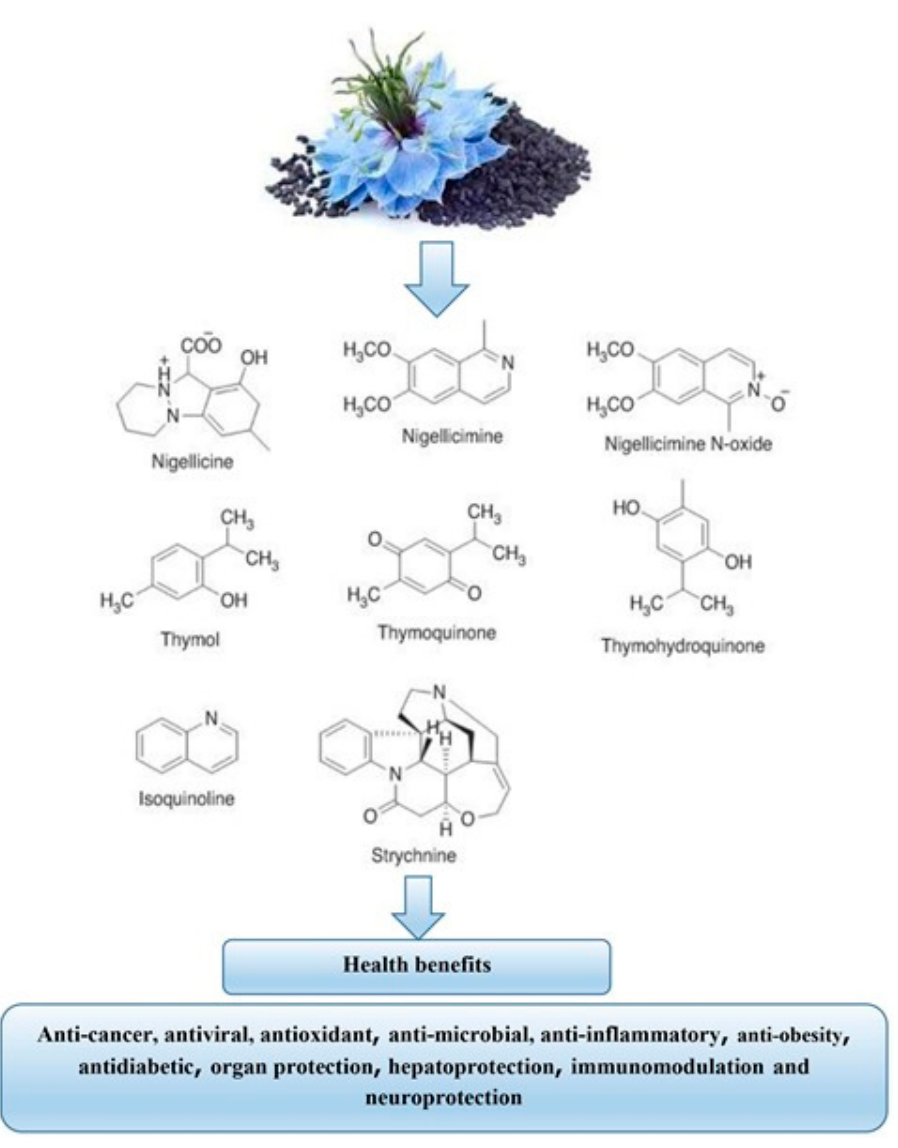
Figure 2. Nigella sativa health benefits.